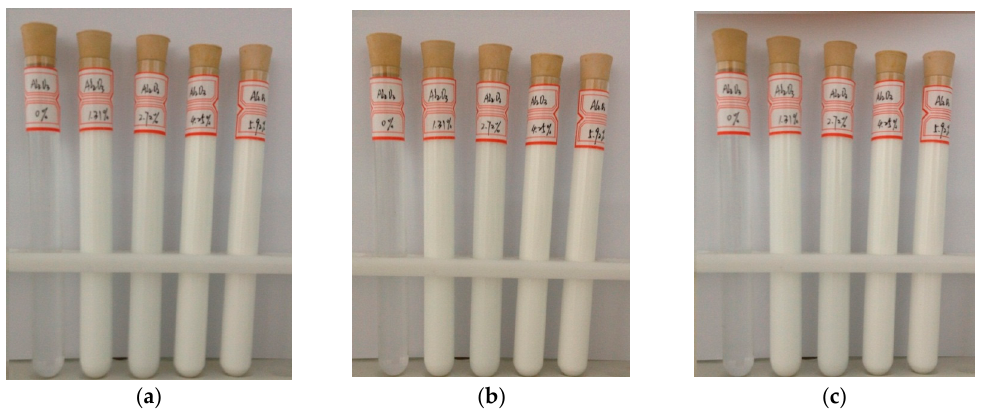
Figure 1. The manufactured Al 2 O 3 -water nanofluids with different nanoparticle volume fractions after different standing times; ( a ) 0 h; ( b ) 36 h; ( c ) 72 h.